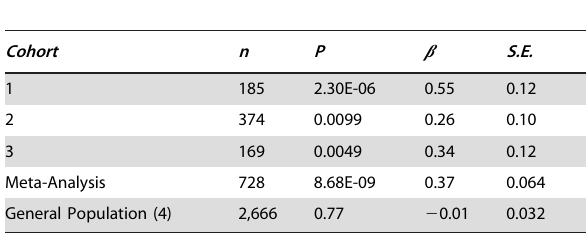
Table 3. The intronic marker rs7182874 (ancestral allele=C; derived, minor allele=T) within the gene PCSK6 on chromosome 15 is associated with relative hand skill in individuals with reading disability.